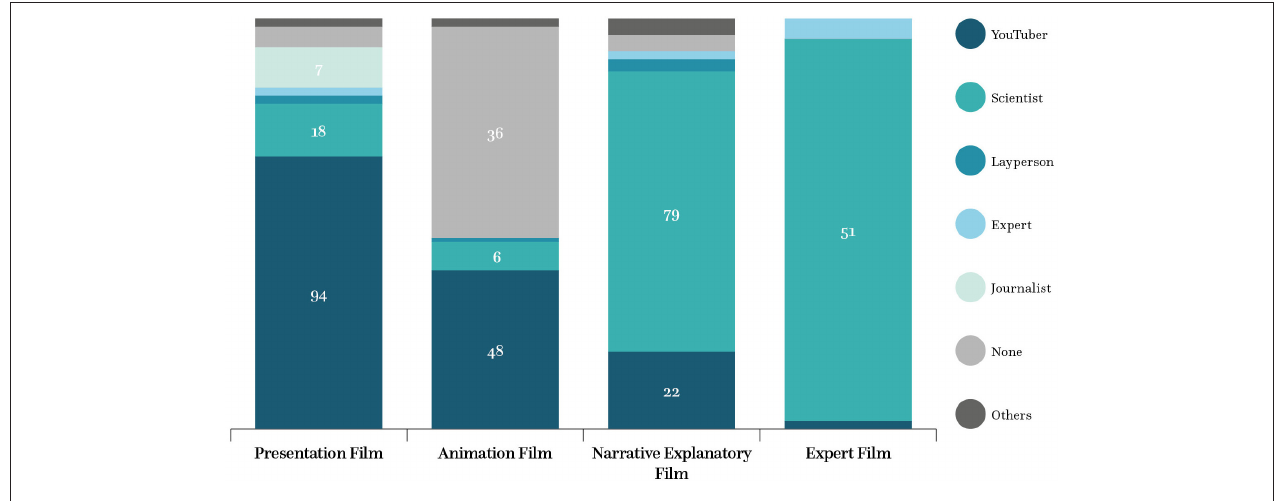
FIGURE 2 | Main actors in the different types of videos ( n =